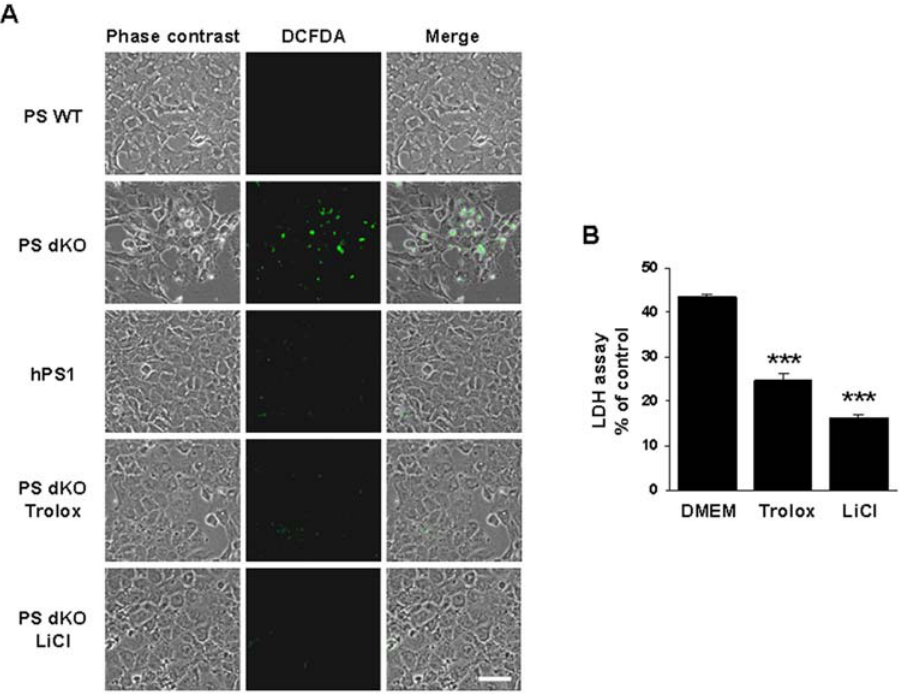
Figure 2. ROS-mediated serum deprivation-induced cell death in PS dKO MEFs. (A) ROS generation of MEFs was detected using the DCFDA fluorophore. All MEFs were incubated in DMEM w/wo 200 m M trolox or 10 mM LiCl for 36 hr. PS dKO MEFs showed higher signal intensities, but hPS1-rescued MEFs and trolox- or LiCl -treated PS dKO MEFs had lower signals. The white bar represents 50 m m. (B) PS dKO MEFs were incubated in the presence or absence of 200 m M trolox or 10 mM LiCl in DMEM for 36 hr. LDH release assay showed that both trolox and LiCl efficiently protected against serum deprivation-induced cell death. The graph represents (%) of positive control. Data are means 6 SEM values of three independent experiments. * represents significant differences from untreated PS dKO MEFs. ***P ,